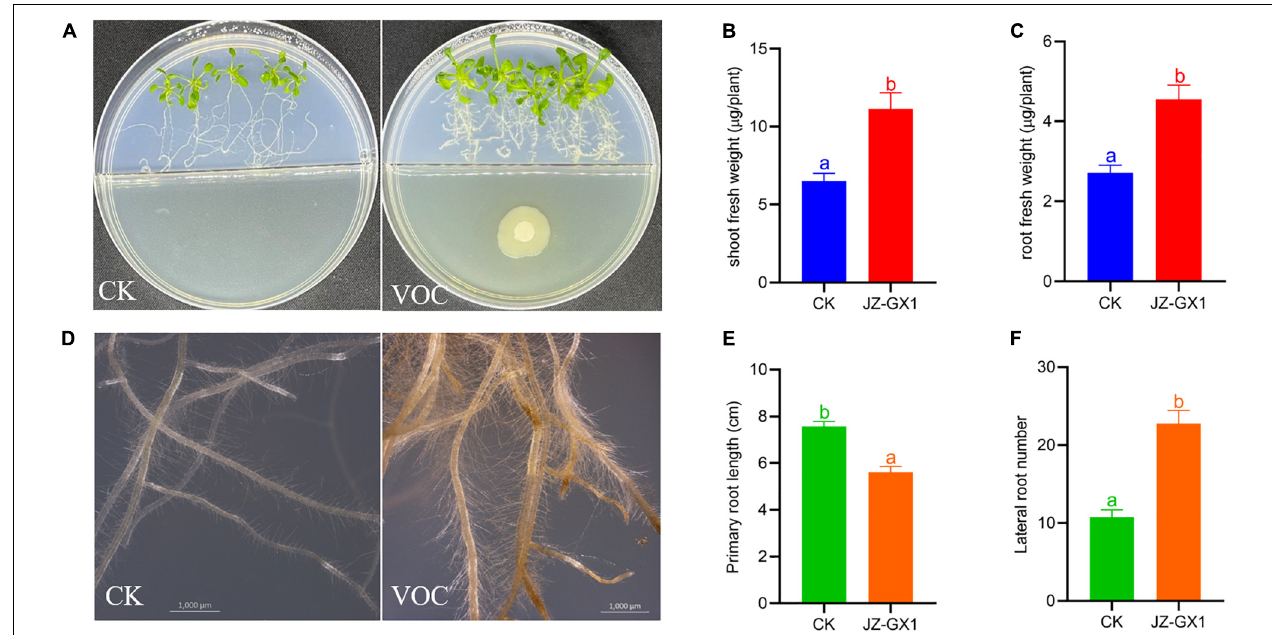
FIGURE 5 | Effect of Rahnella victoriana JZ-GX1 VOCs on plant growth and root morphology of Arabidopsis thaliana compared to the control (CK). (A) Plant phenotype, (B) shoot fresh weight, (C) root fresh weight, (D) root morphology, (E) primary root length, (F) lateral root length. The scale is 1,000 µ m. Different letters indicate statistically significant differences among treatments (Student’s t -test, p < 0.01) ( n =